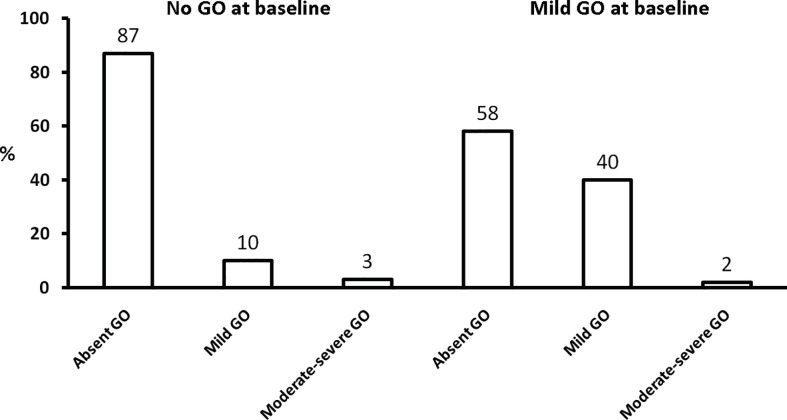
Natural history of Graves’ orbitopathy (GO) at the end of antithyroid drug treatment according the absence (n = 194) or presence (n = 43) of mild GO at baseline. Derived from Tanda et al. (13).